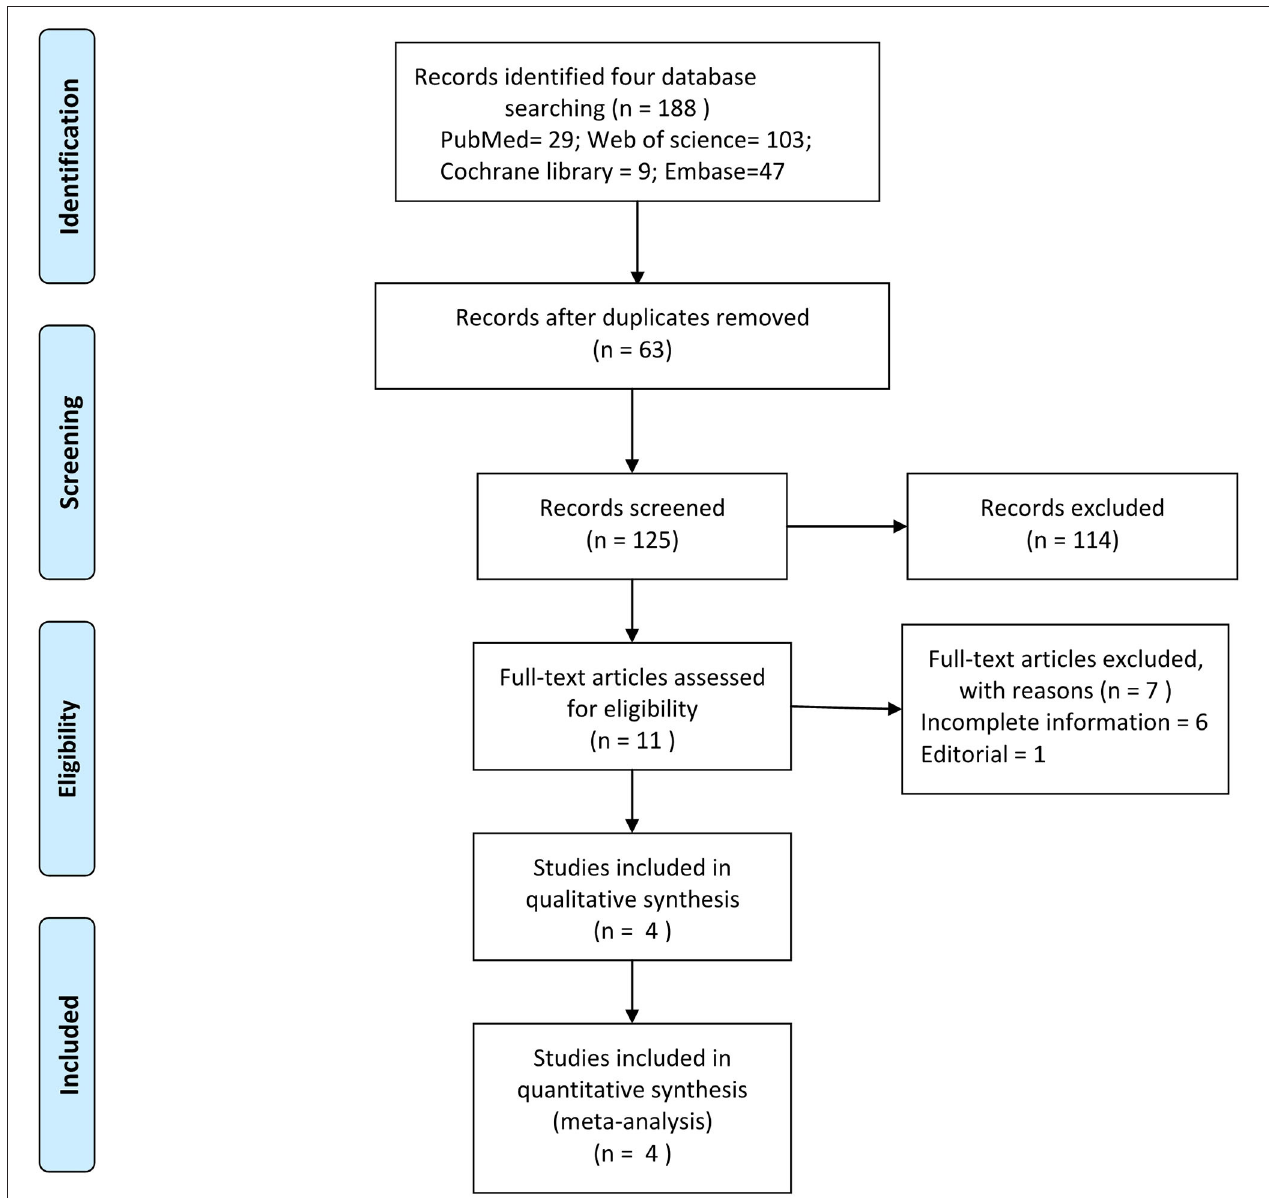
FIGURE 1 | Flow diagram for the study identified and included into this